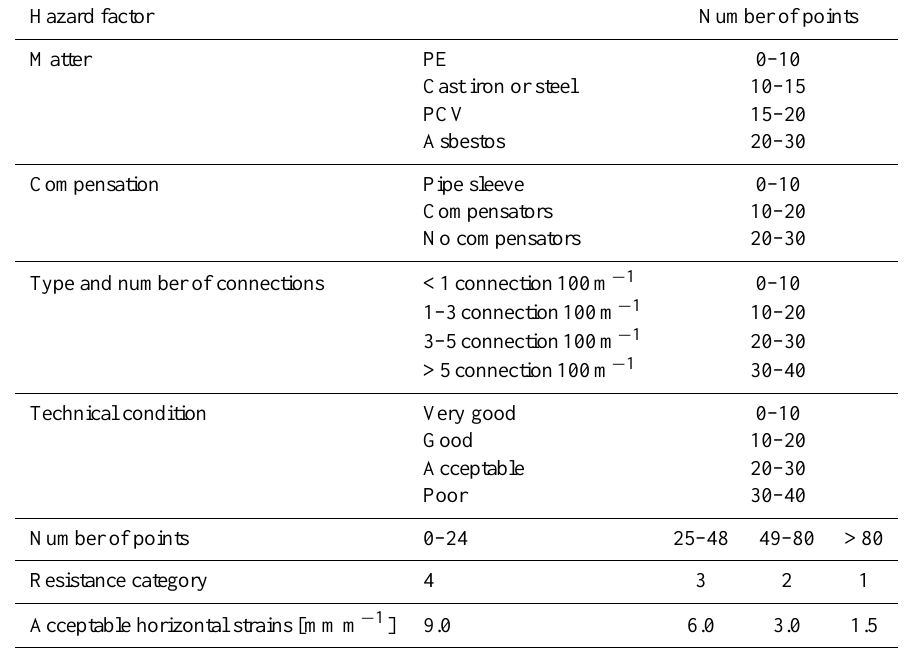
Table 1. Resistance classification of water pipelines – point method.